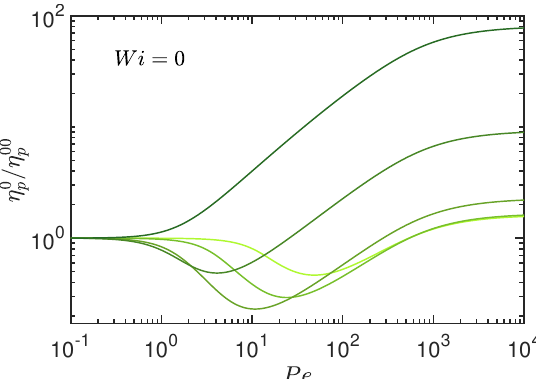
Figure 9. Zero-shear viscosity η 0 p normalized by the zero-shear viscosity η 00 p of a passive polymer as function of the Péclet number Pe for the polymer stiffness pL = 100, 10, 1, 0.1, and 0.01 (top to bottom at Pe = 10 4 , dark to bright color). The number of active sites is L / l = 10 2 and ∆ =